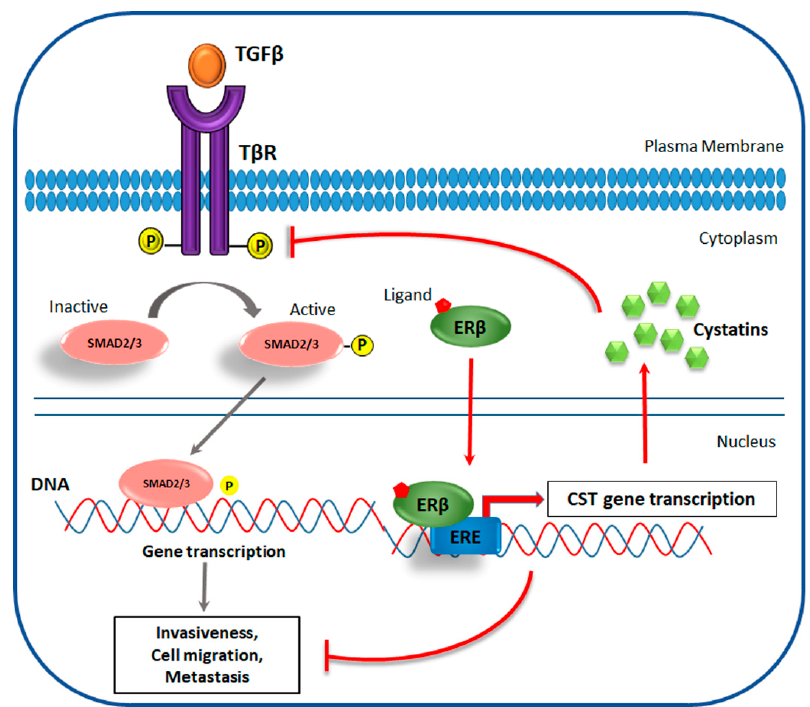
Figure 2. Proposed mechanism of ER β‐ mediated inhibition of metastatic phenotype via suppression of TGF ‐β signaling in TNBC. In cancer cells, TGF ‐β /SMAD pathway drives invasiveness, cell migration, and metastasis formation. Ligand ‐ activated ER β blocks these processes by binding EREs in the CST genes, enhancing cystatin gene expression; cystatins, in turn, block canonical TGF β signaling directly interacting with the TGF β receptor (T β R), reducing SMAD2 and SMAD3 phosphorylation.